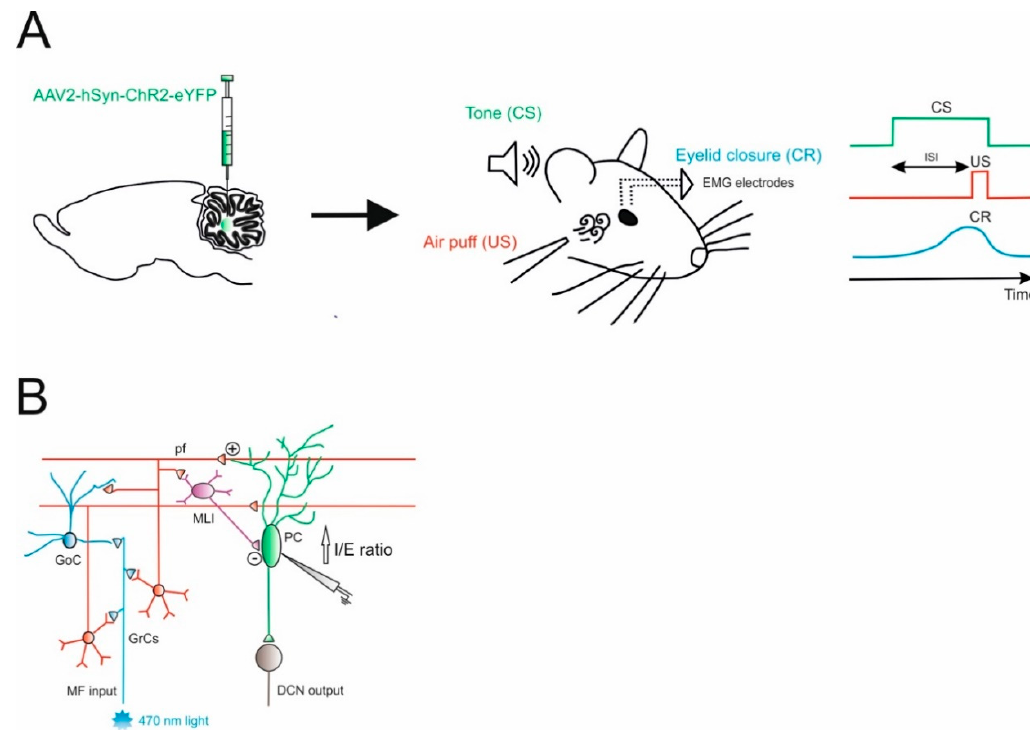
Figure 1. Role of Excitatory Cerebellar Nucleocortical Circuit in controlling associative motor learning. ( A ) Left , schematic viral injection of AAV2-hSyn-ChR2-eYFP targeting the interposed nucleus. Right , in the eyeblink conditioning (EBC) paradigm, a conditioned stimulus (CS, tone) is presented before the onset of an unconditioned stimulus (US, air puff). The inter-stimulus interval (ISI) is the time interval between CS and US onset. The two stimuli normally co-terminate. During the training, mice learn to generate a delayed conditioned response (CR) to the CS before the onset of the expected US. ( B ) Mossy fiber (MF) afferents can influence deep cerebellar nuclei (DCN) output via projections onto granule cells (GrCs). GrCs can directly affect Purkinje cell (PC) activity via parallel fiber connections or indirectly via feedforward GrC-MLI-PC processing. The EBC paradigm increases the inhibitory/excitatory (I/E) ratio in PCs, indicating a preferential enhancement of the feedforward inhibitory GrC-MLI-PC pathway.